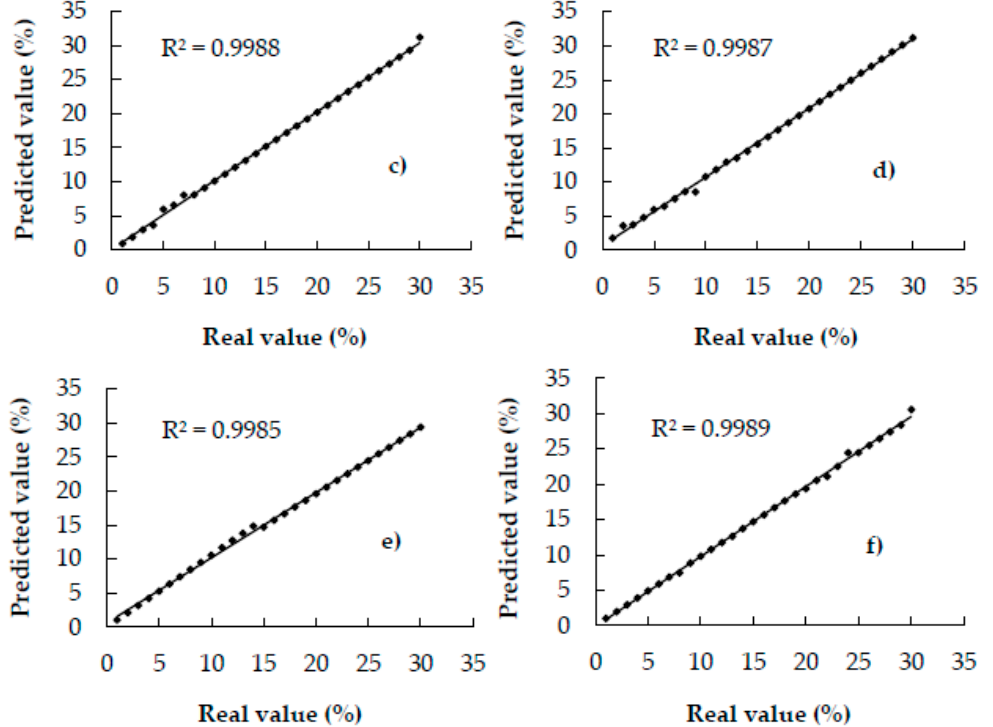
Figure 3. Scatter plots of actual and predicted values of coffee adulterated with—( a ) coffee husks, ( b ) corn, ( c ) barley, ( d ) soy, ( e ) oat, and, ( f ) rice of calibration samples.